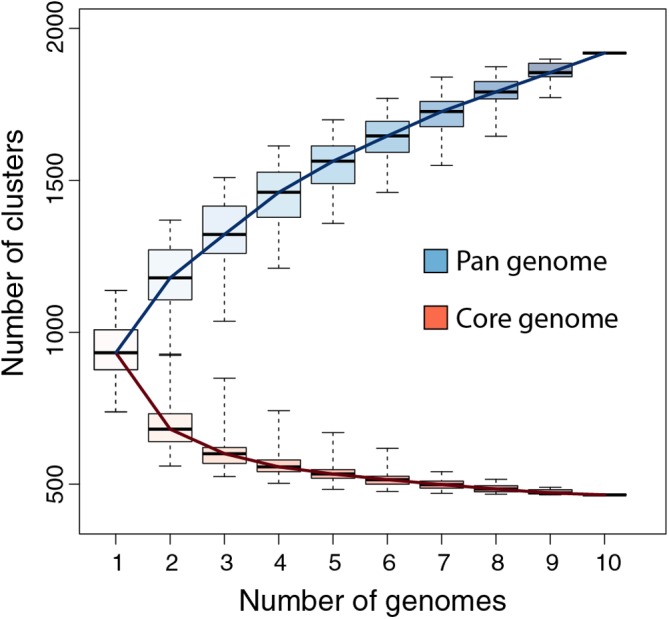
Pandoraviridae pan-genome and core-genome. The boxplot represents the number of protein clusters as a function of the number of sequenced genomes in all possible combinations. The whiskers correspond to the extreme data points.